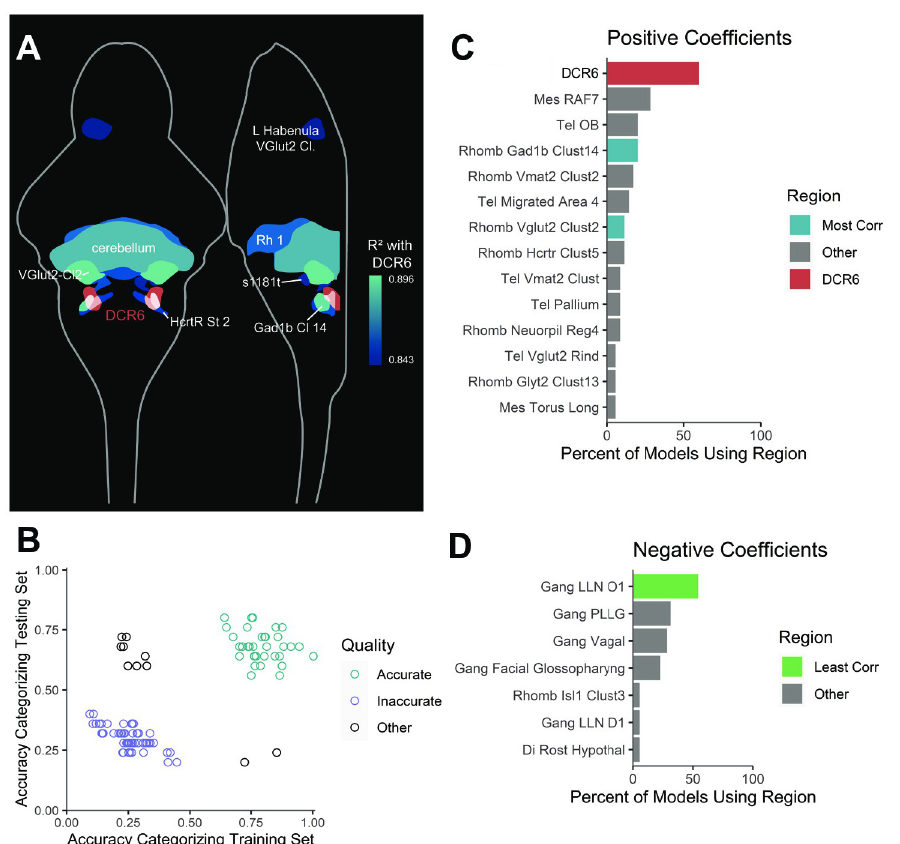
Fig 6. Methods for identifying alternative candidate regions. A) Anatomical map of regions with the highest correlations (Pearson R 2 ) with the DCR6. The DCR6 is indicated in red; correlating regions are indicated in shades of blue, with brighter color indicating greater correlation. The majority of regions that correlate highly with the DCR6 are nearby within the dorsal rhombencephalon. Some regions were excluded due to anatomical overlap with regions shown or because they physically contain the entire DCR6; see Supplemental Information full results. Abbreviations, in descending order of correlation strength: DCR6 –Dorsal cluster Rhombomere 6 (“Rhombencephalon—QRFP Neuron Cluster Sparse”); VGlut2 Cl2 –“Rhombencephalon—VGlut2 Cluster 2”; Gad1b Cl 14 –“Rhombencephalon— Gad1b Cluster 14”; Cerebellum–“Rhombencephalon—Cerebellum”; Rh 1 –“Rhombencephalon—Rhombomere 1”; HcrtR St 2 –“Rhombencephalon—6.7 DHCrtR Gal4 Stripe 2”; s1181t –“Rhombencephalon—s1181t Cluster”; L Habenula VGlut2 Cl–“Diencephalon—Left habenula VGlut2 Cluster” B) Training and testing set accuracy of 100 LASSO regression models created by bootstrapping data from n = 50 CaSR WT larvae expressing UAS:CaSR-EGFP under control of α tubulin:Gal4. Most models fall into one of two categories: accurate (greater than 50% accuracy on both training and testing sets, sea green, n = 35) or inaccurate (less than 50% accuracy on both training and testing sets, purple, n = 55). Datapoints are jittered to avoid overplotting. We hypothesize that the inaccurate models are the result of declining statistical power associated with halving sample size for bootstrapping. For all further analysis, only accurate models were used. C) Regions that received positive coefficients in more than one bootstrapped, accurate LASSO model. The most common region employed in accurate models was the DCR6 (red). Two other regions that are among the top 10 most correlated with the DCR6 (see Fig 5A and S1 File) also appeared (blue). The other regions (gray) may explain some of the variability in phenotype that was not explained by the DCR6. Abbreviations: DCR6 –“Dorsal Cluster Rhombomere 6” (ZBrain: “Rhombencephalon–QRFP Neuronal Cluster Sparse”); Mes RAF7 –“Mesencephalon—Retinal Arborization Field 7 (AF7)”; Tel OB–“Telencephalon—Olfactory Bulb”; Rhomb Gad1b Clust14 –“Rhombencephalon—Gad1b Cluster 14”; Rhomb Vmat2 Clust2 –“Rhombencephalon—Vmat2 Cluster 2”;